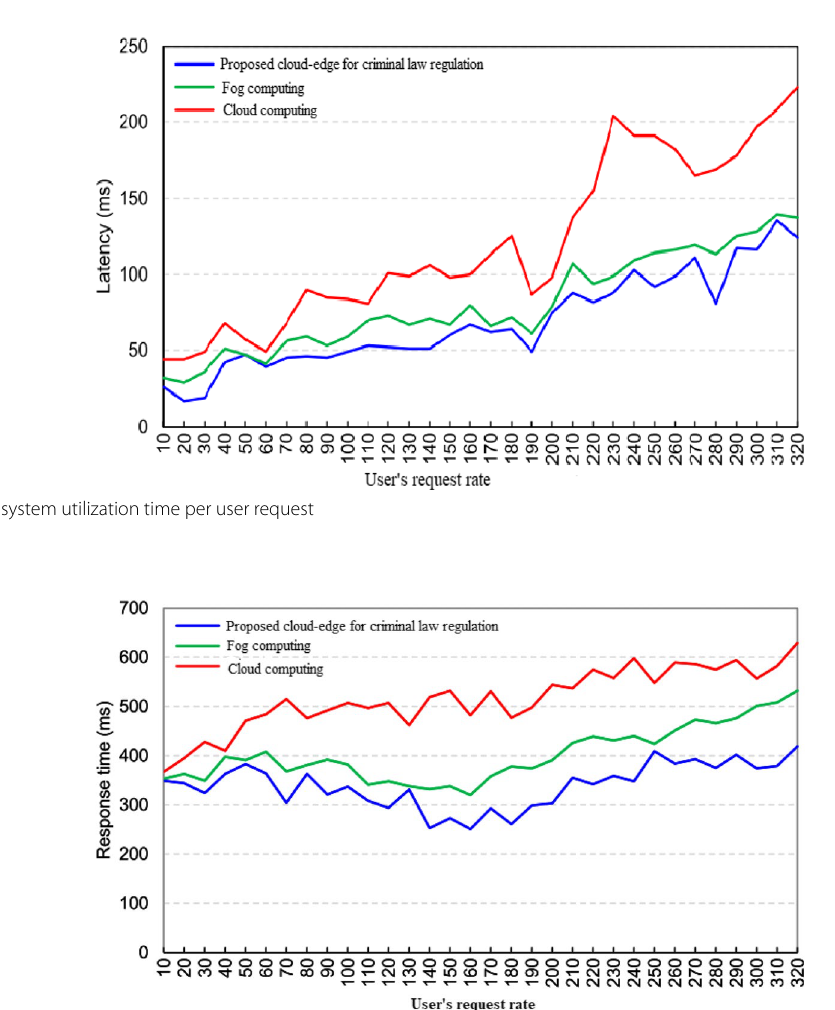
Fig. 12 Average system latency per user